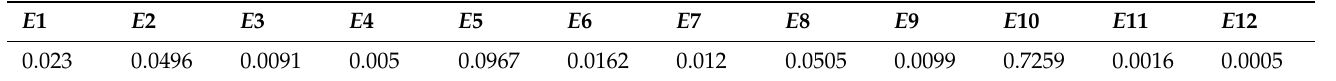
Table 3. Mean values of disbursements and incomes for